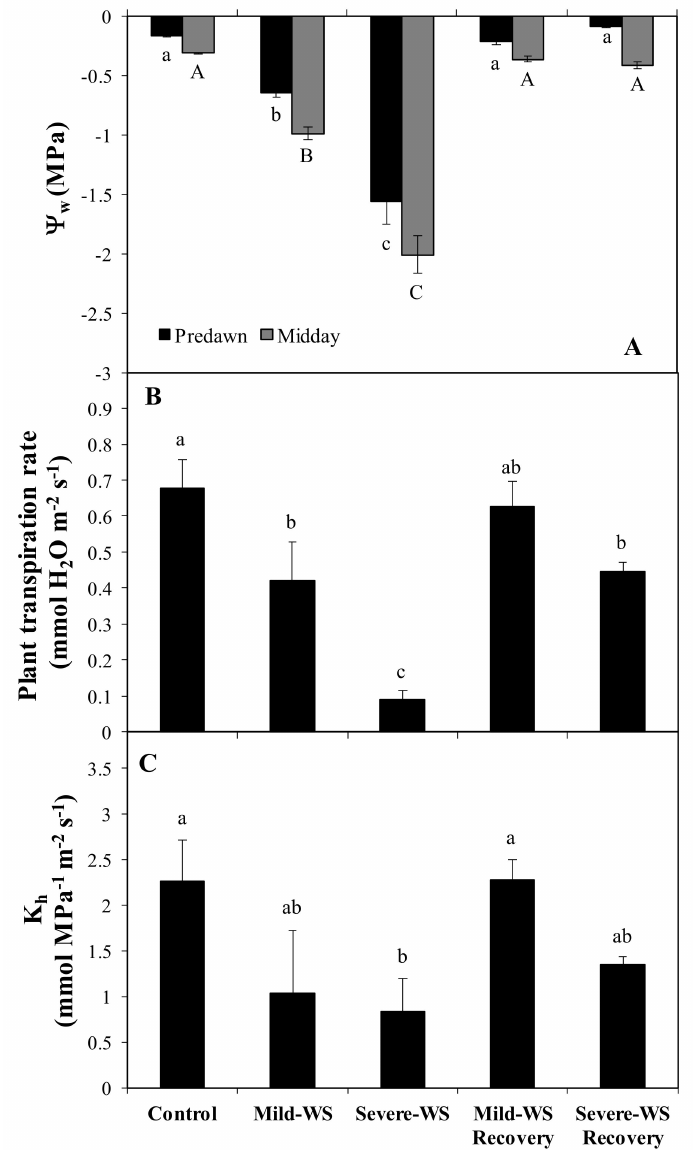
Figure 3. Predawn and midday water potential ( Ψ w; A ), plant transpiration rate ( B ), and plant hydraulic conductance ( K h ; C ) from ‘Dusa’ avocado rootstock subjected to two different levels of water stress: mild-WS (50% of Fc) and severe-WS (25% of Fc (mean ± SE; n = 4) and their corresponding recovery. Within each series, different capital or lowercase letters indicate significant differences among treatments ( p <